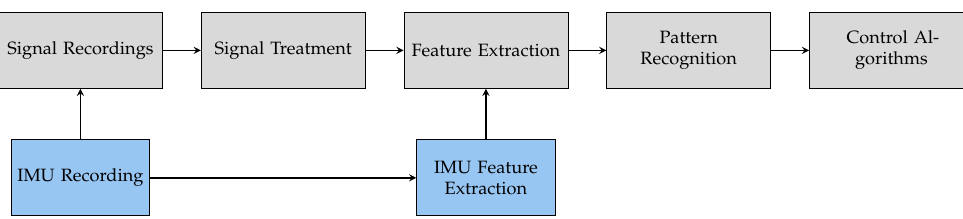
Figure 4. BioPatRec modules adapted from [53] and newly developed extensions for IMU processing (marked in gray and blue,